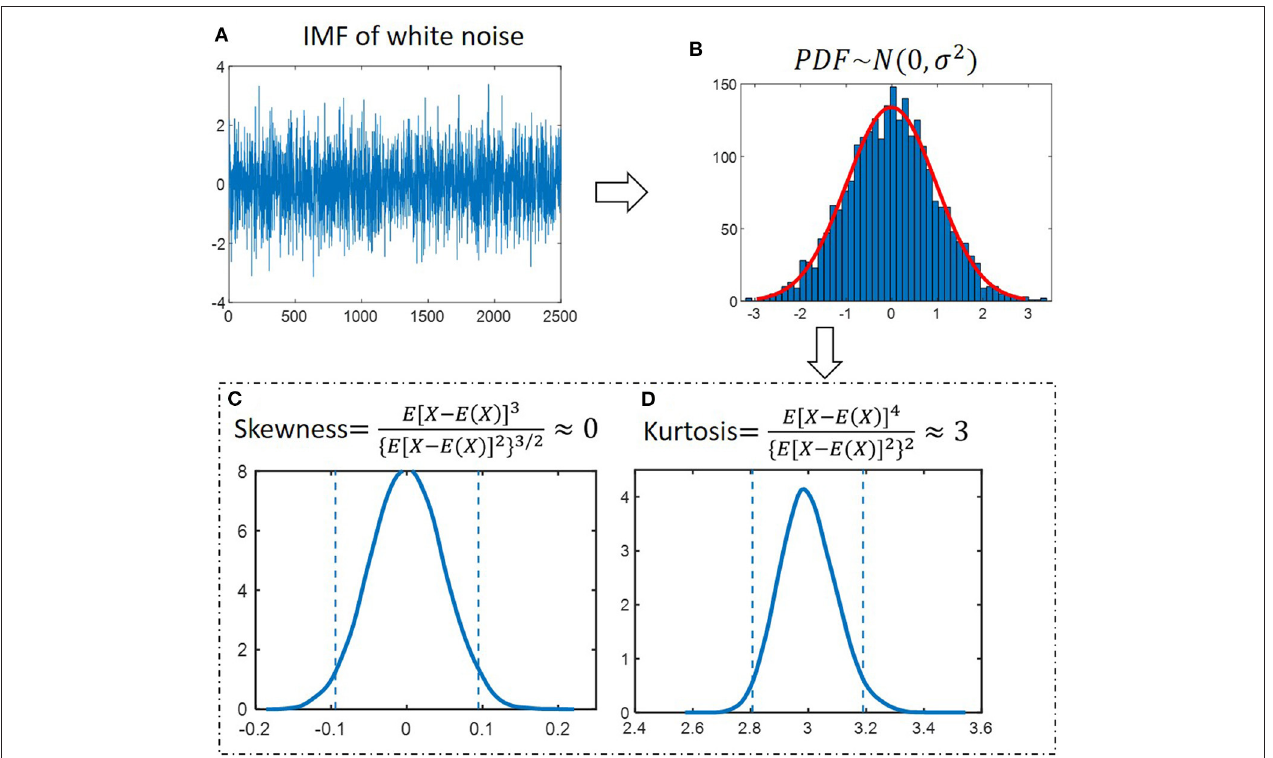
0.09 and 0.09 depict the −